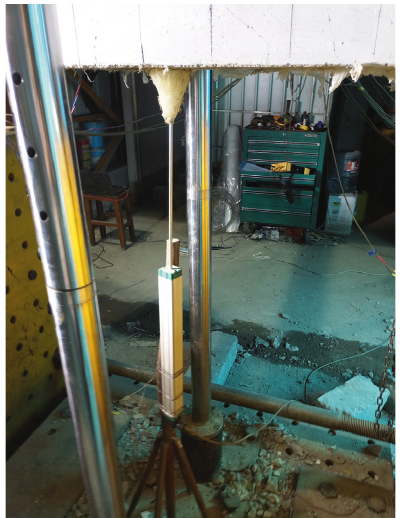
Figure 5: Displacement